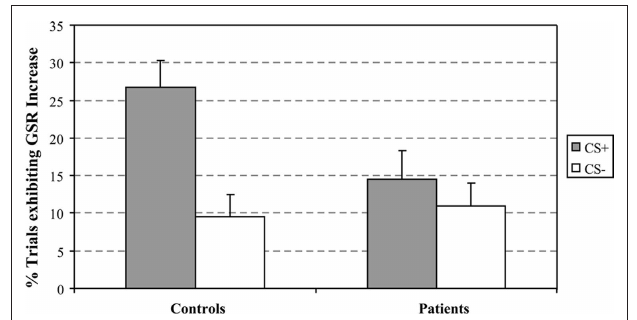
FIGuRe 1 | Percent of trials exhibiting an increase in GSR values from baseline following CS+ and CS−